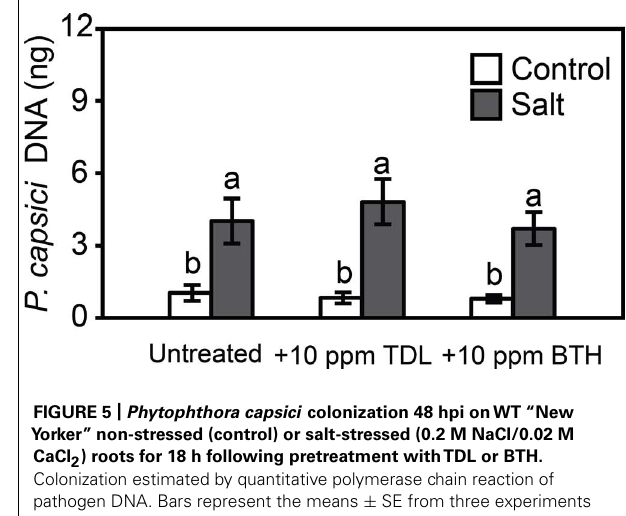
FIGURE 5 | Phytophthora capsici colonization 48 hpi onWT “New Yorker” non-stressed (control) or salt-stressed (0.2 M NaCl/0.02 M CaCl 2 ) roots for 18 h following pretreatment withTDL or BTH. Colonization estimated by quantitative polymerase chain reaction of pathogen DNA. Bars represent the means ± SE from three experiments ( n = 9 for each treatment). Letters indicate significant differences between treatments by T -test ( α =